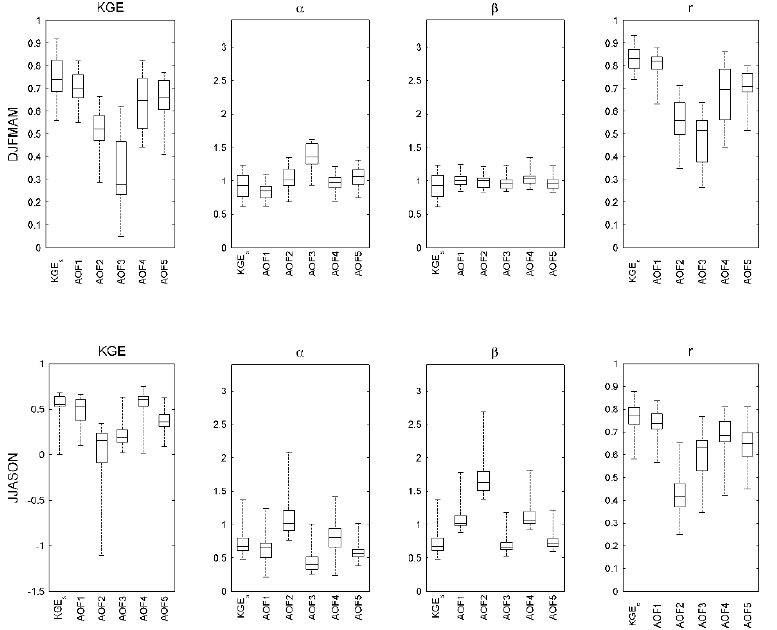
Figure A2. Hydrologic annual performance over the validation period for the Nicolet Sud-Ouest catchment (see Figure 6 for further description).